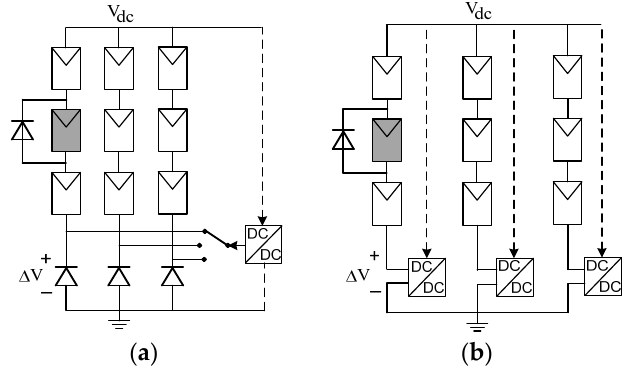
Figure 15. String series (voltage) compensation: converter per array ( a ); converter per string ( b ).